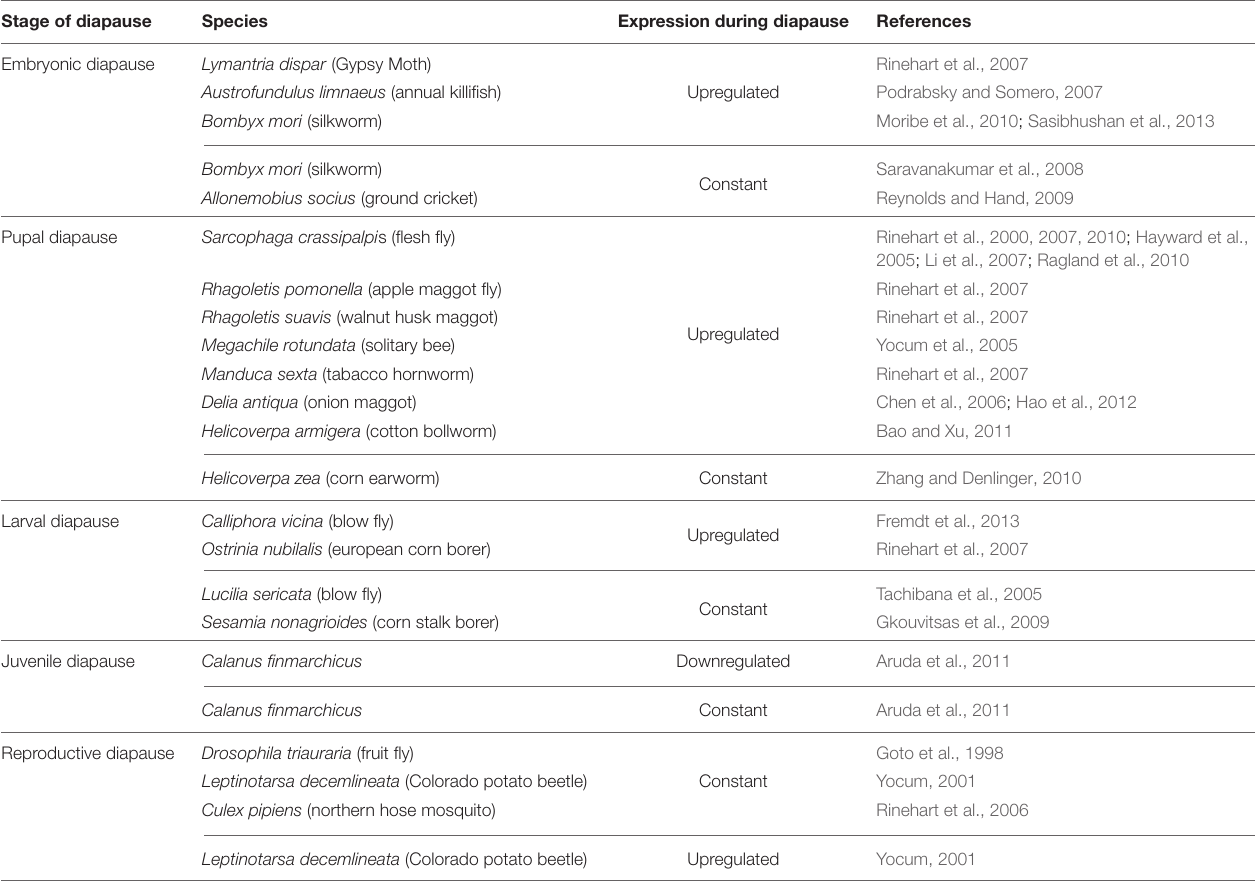
TABLE 1 | An overview of expression of Hsp70 family during diapause in different